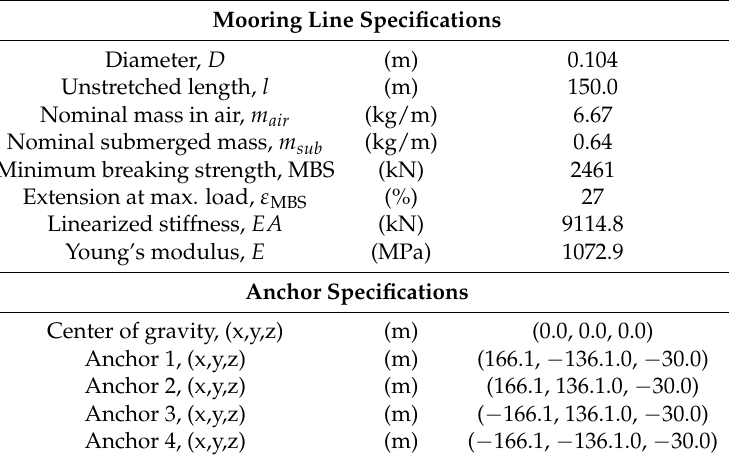
Table 6. Mooring line and anchor specifications.